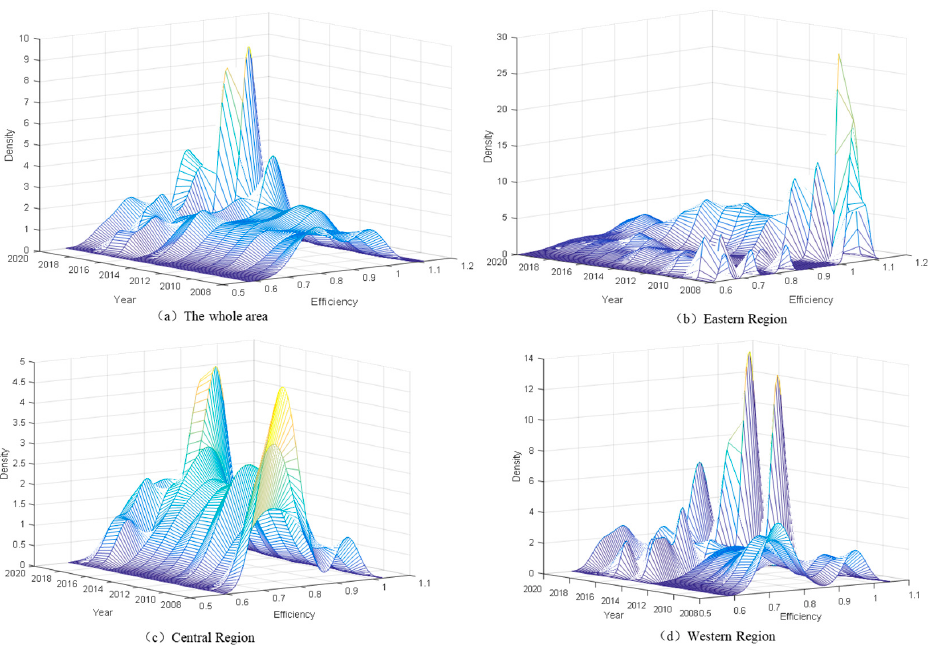
Figure 5. Three-dimensional Kernel density curves for ( a ) the whole area; ( b ) eastern region; ( c ) central region; ( d ) western region. Data source: obtained through Kernel density estimation according to the data in Table